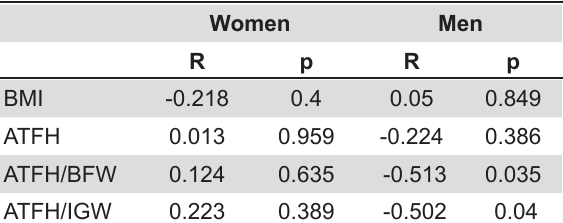
Table 1- Pearson’s correlation analysis of body mass index (BMI). Anterior total facial height (ATFH). Anterior total facial height/bizygomatic facial width (ATFH/BFW). Anterior total facial height/intergonial width (ATFH/IGW) with maximum bite force (kg) in women and men